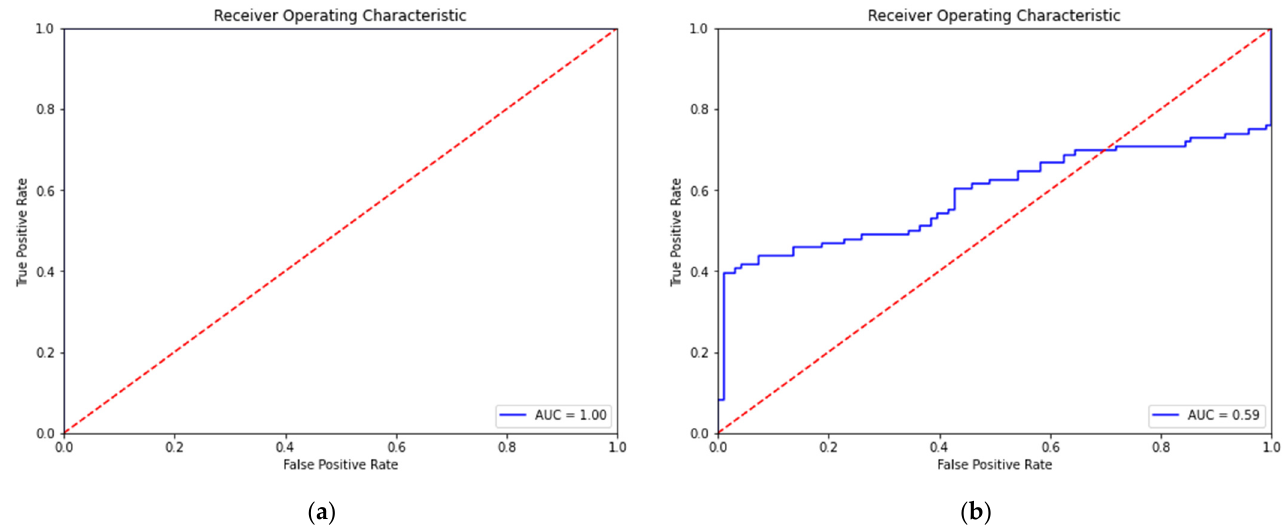
Figure 8. The Receiver Operating Characteristics (ROC) curves of the proposed algorithm over the appearance property for the ( a ) horizontal view and ( b ) 45° angle view model.